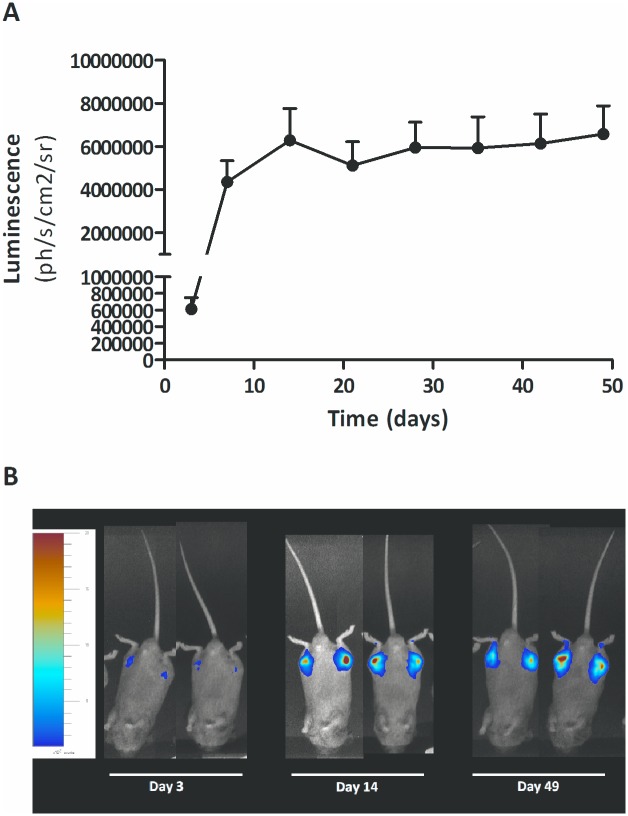
Luminescence of rAAV5-CMV-Fluc detected during longitudinal follow up after intra-articular administration.Expression was monitored for a total of 7 weeks. Expression is visible as early as the first imaging moment (day 3) and remained stable up till day 49 (A). Images over time of 2 representative animals are shown for day 3, 14 and 49 (end of experiment)(B). Data are shown as mean + SEM, N = 5.